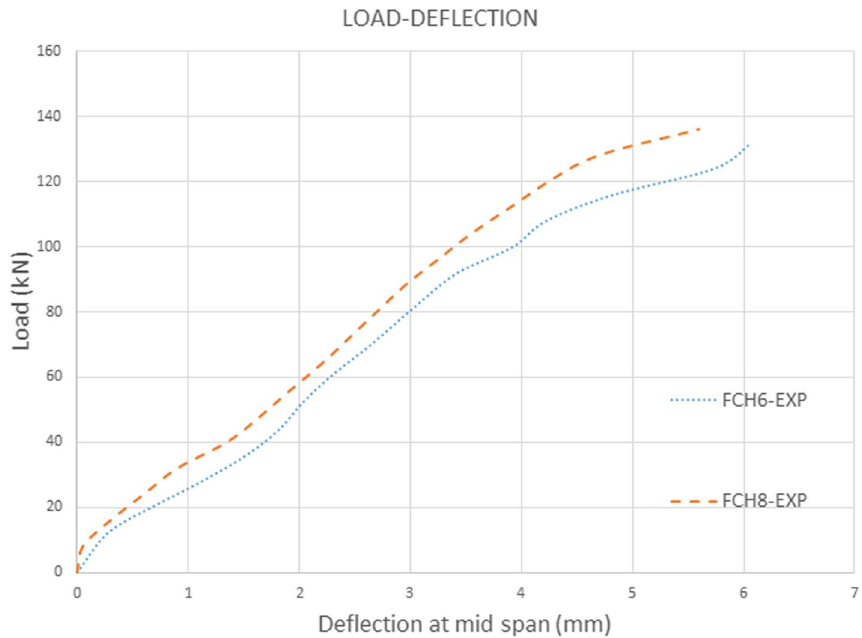
Fig. 21 Load vs. mid-span deflection curves for FCH6 and